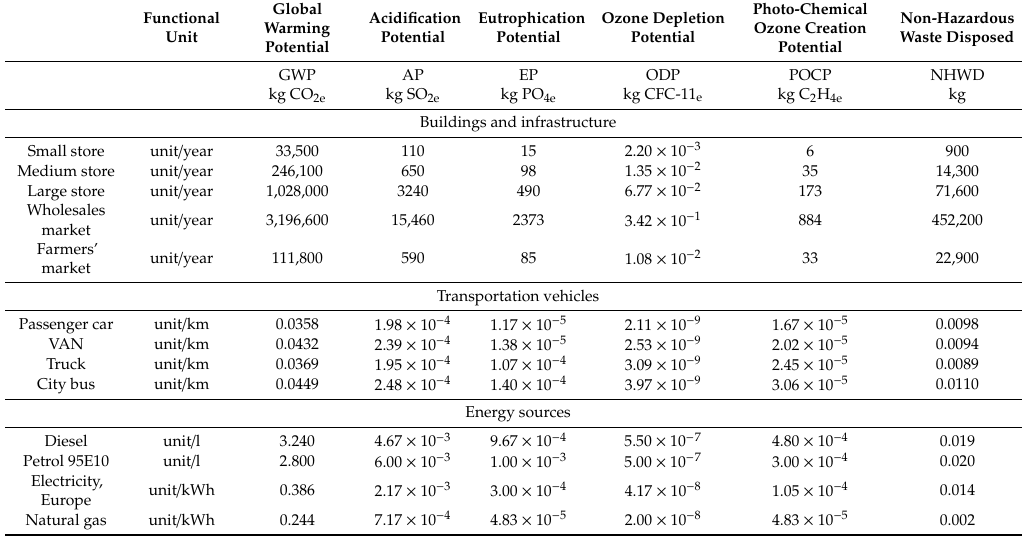
Table A1. Environmental parameters for eco-e ffi ciency